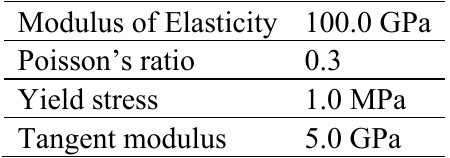
Table 1. Material properties of test specimen used for test case comparisons.